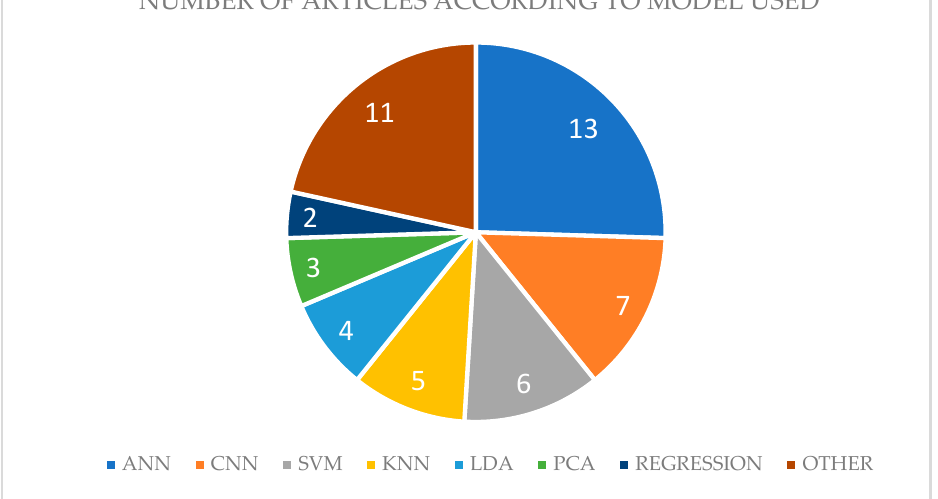
Figure 2. The number of articles categorised by different machine learning models and algorithms.